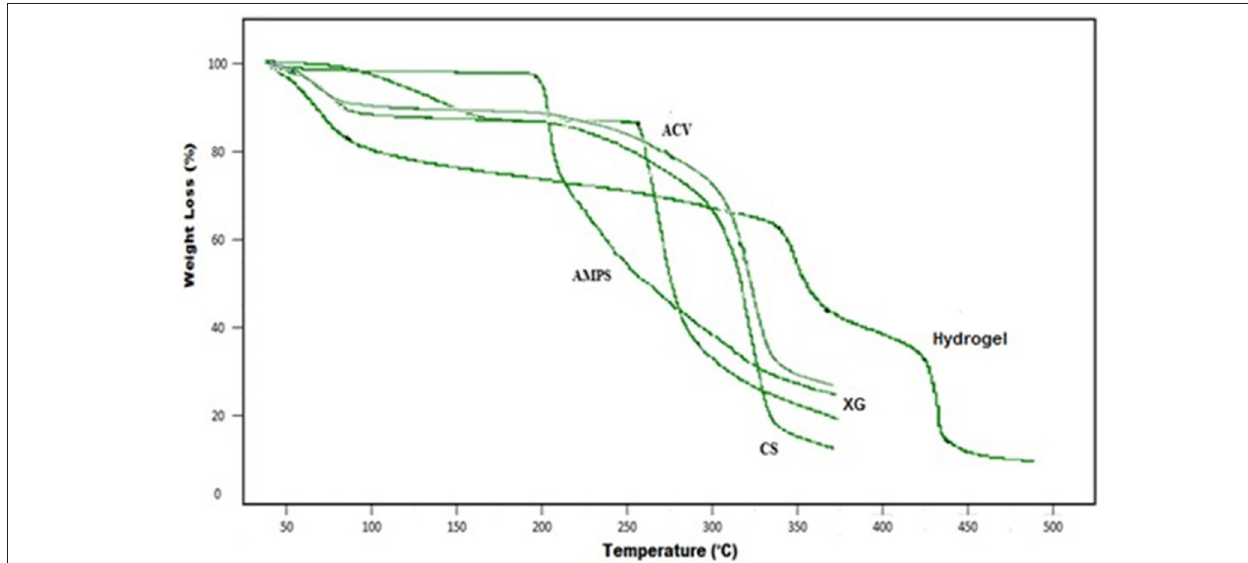
FIGURE 2 | TGA curve of ACV, AMPS, CS, XG, and Hydrogel.